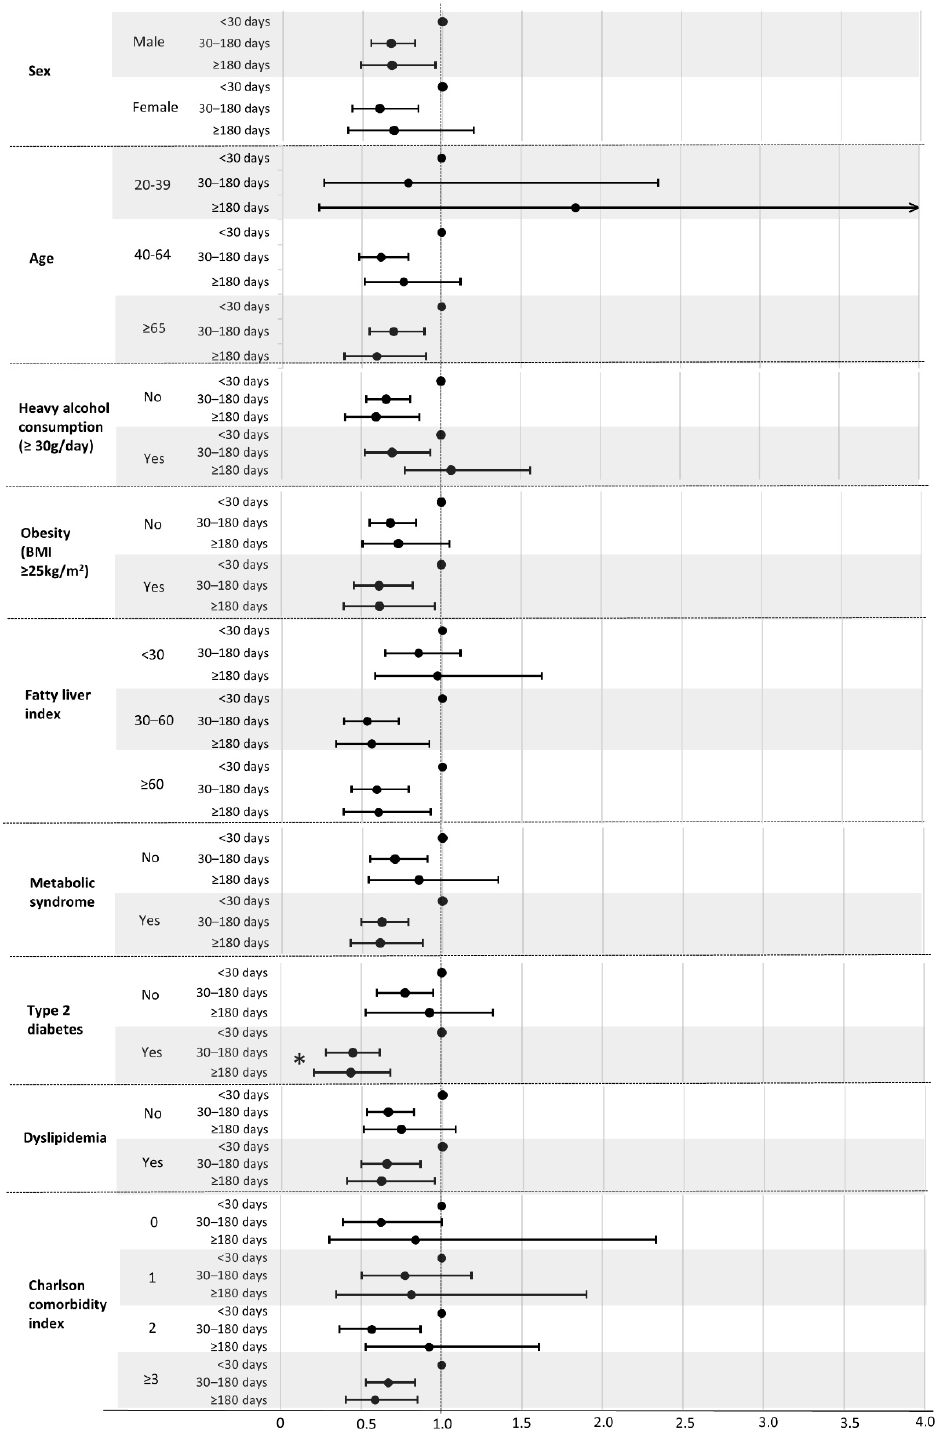
Figure 2. Subgroup analysis of all-cause mortality according to duration of carnitine-orotate complex use. HRs (95% CIs) were calculated using a multivariable Cox proportional hazard regression